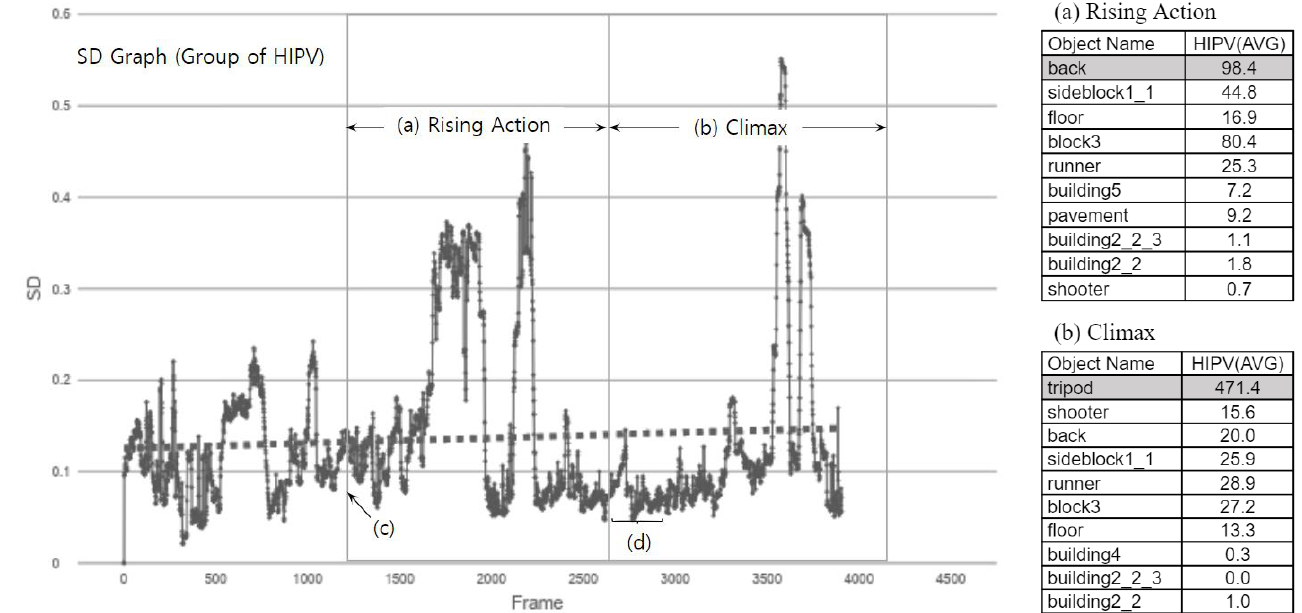
Figure 7. HIPV Group in the Rising Action and Climax (Standard Deviation ( left ) and Objects Most Seen ( right )).